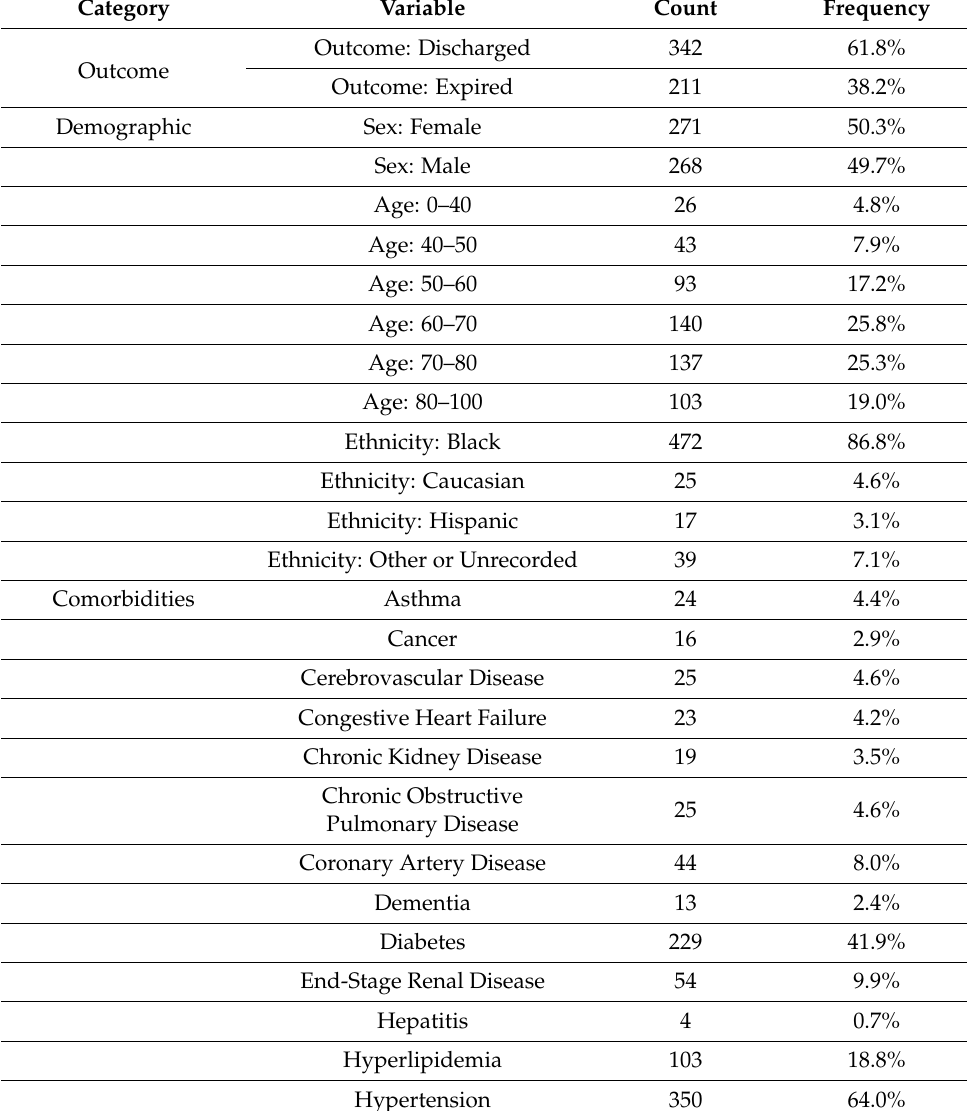
Table 1. Summary of patient characteristics. Note, that a number of variables have missing observa- tions meaning that the totals across all groups do not sum to the total number of patients ( n = 553): for example, there were 14 patients whose sex was not